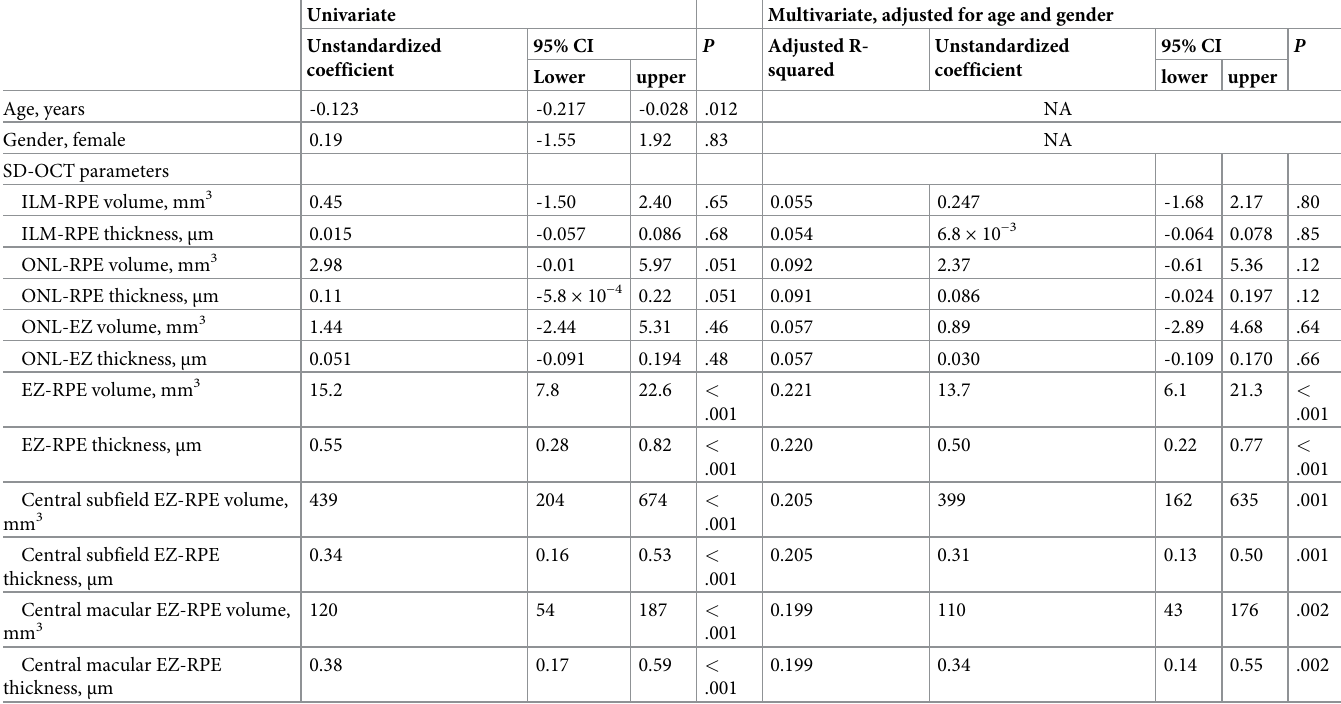
Table 2. Univariate and multivariate linear regression analysis on total brain volume (%ICV). Univariate Multivariate, adjusted for age and